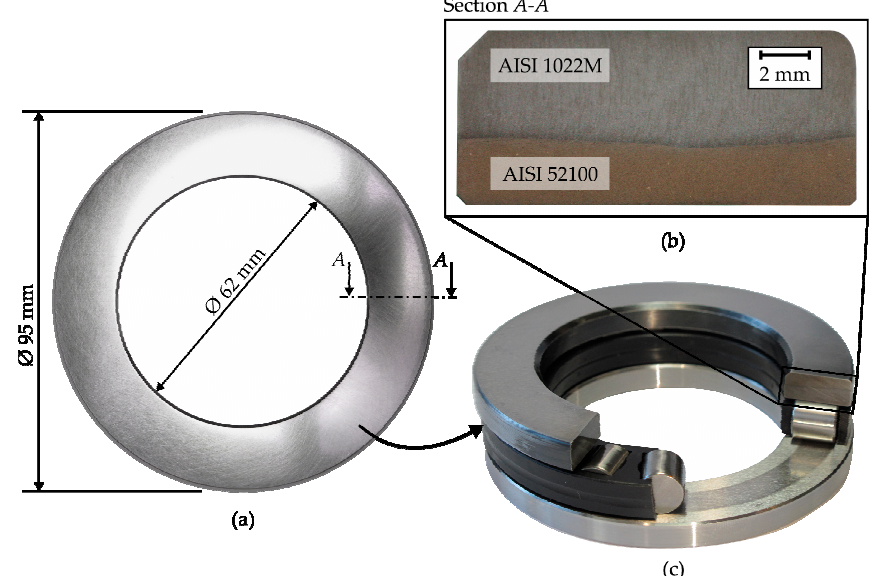
Figure 2. Tailored forming bearing: ( a ) finished specimen as roller bearing raceway; ( b ) sectional view; ( c ) cylindrical roller thrust bearing type 81212.